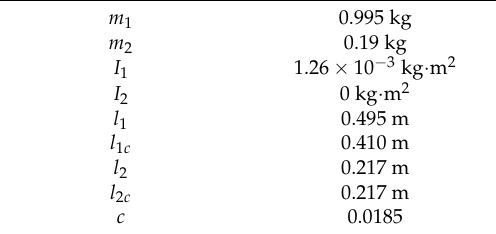
Figure 3. A photo of the MonkeyBot. Table 1. Physical parameters of the robot.